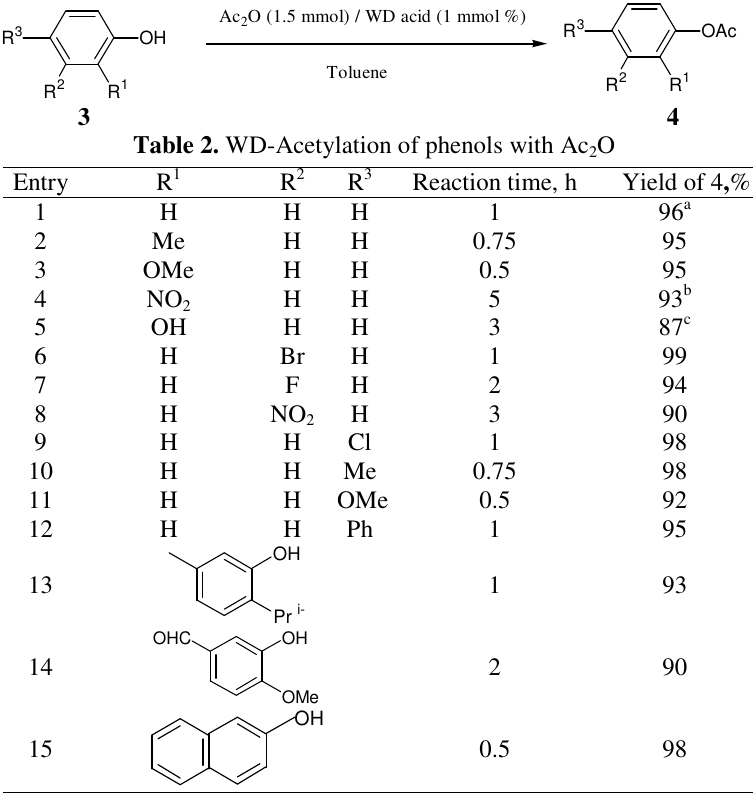
Table 2. WD-Acetylation of phenols with Ac